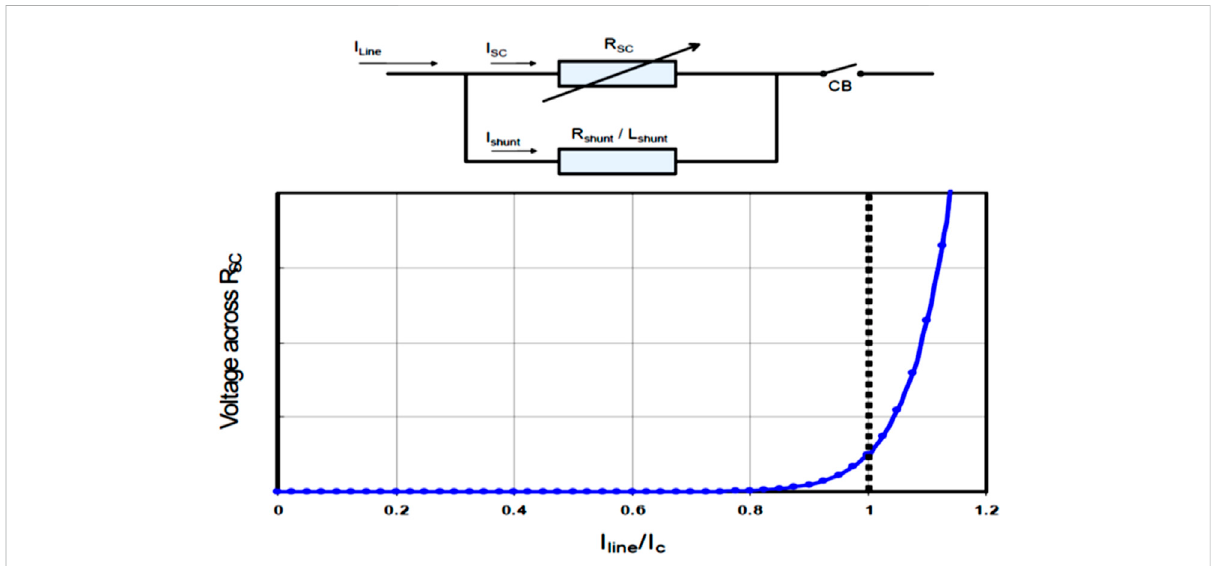
FIGURE 1 Resistive Type SFCL with Shunt Element and a normalized plot of voltage and current in a superconductor at a constant temperature and magnetic fi eld. [Electric Power Research Institute (EPRI), 2009], (Pawar and Chavan, 2017).